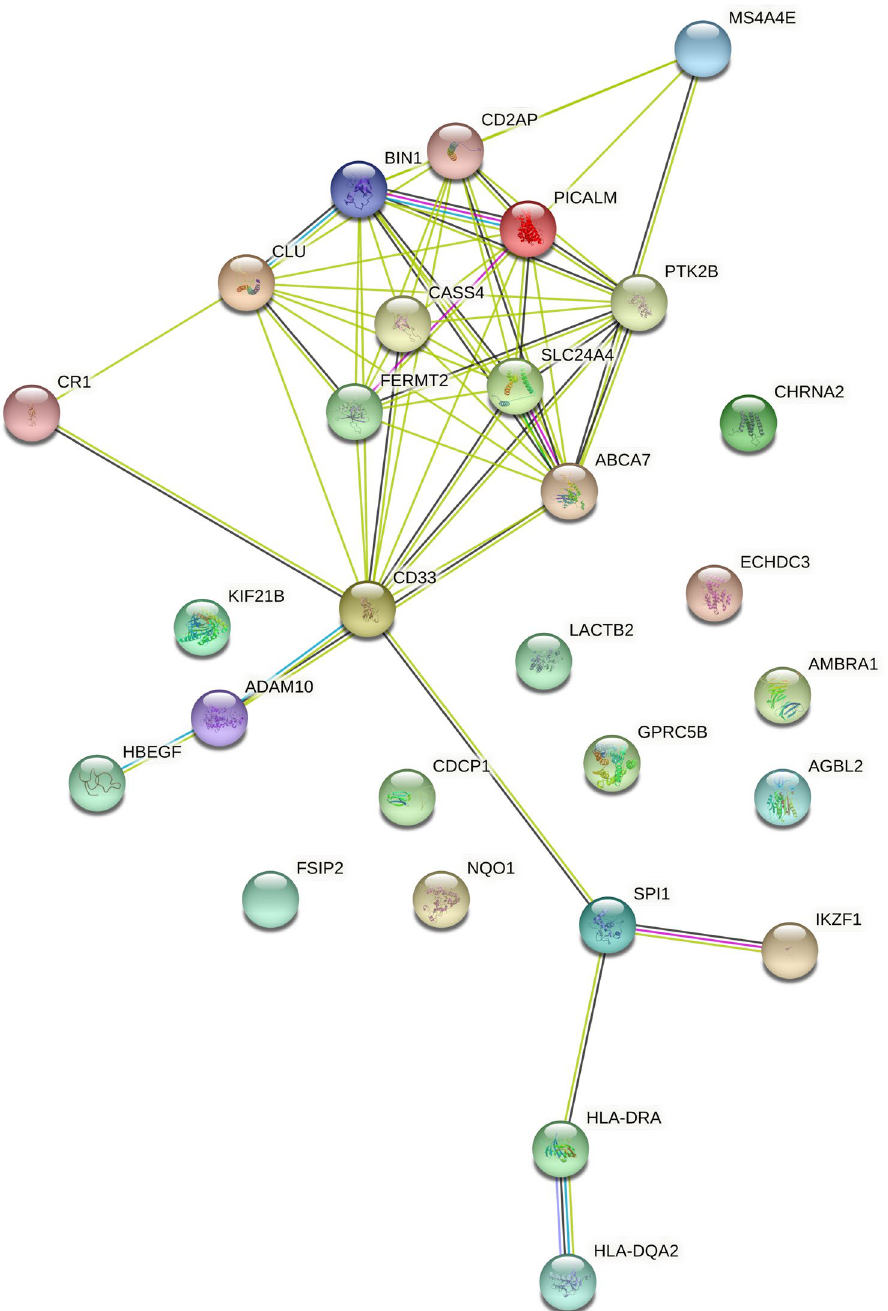
Figure 4. Bioinformatics analysis of Alzheimer’s disease PRS-Alz 5: Protein–Protein Interaction network for the protein-coding genes of the SNPs of PRS-Alz 5 (PPI enrichment p value: < 1.0e−16). Nodes represent the proteins and edges indicate both functional and physical protein association. The edge line thickness shows the strength of data support at an interaction score ≥